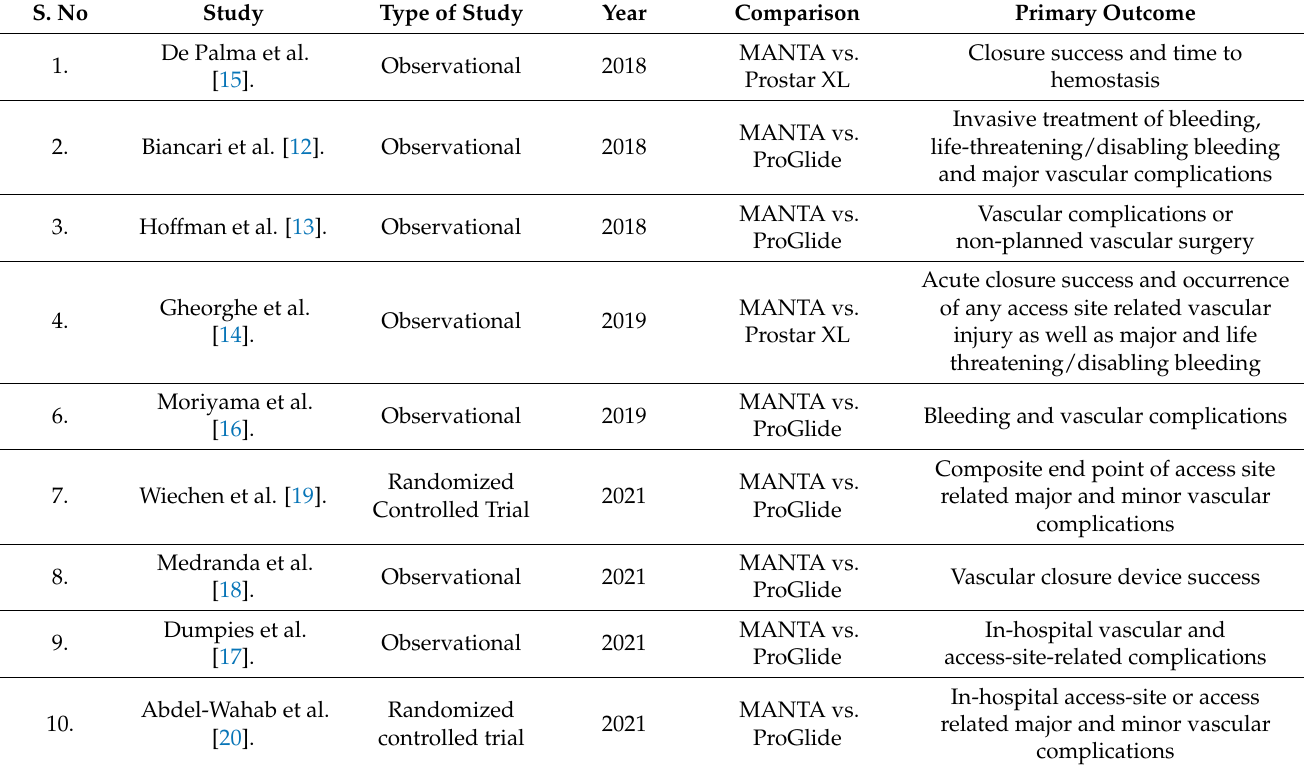
Table 1. Summary of studies included for meta-analysis and brief description of study